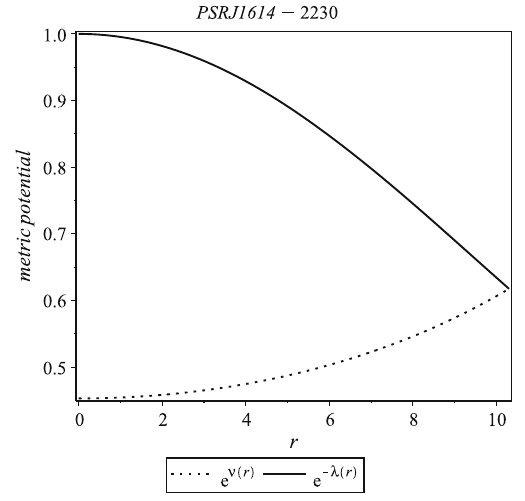
Fig. 1 Variation of e − λ , e ν w.r.t. the radial coordinate r for the strange star candidate PSRJ 1614–2230